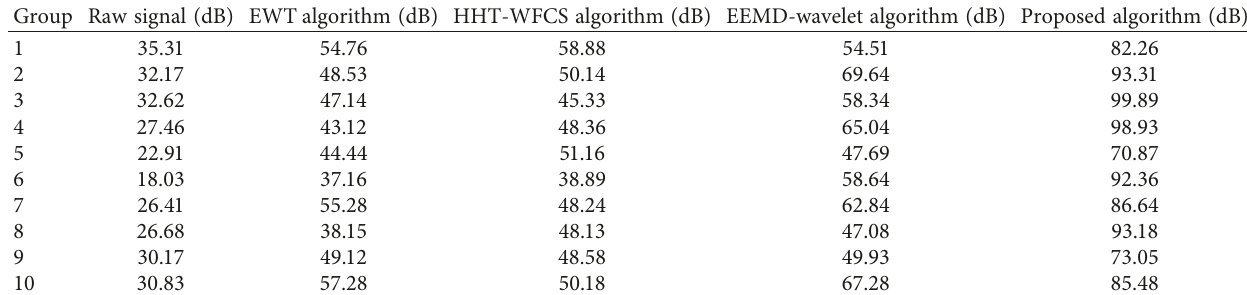
Figure 7: (a) The expanded data before denoising. (b) The expanded data after denoising. Table 1: SNR of several denoising